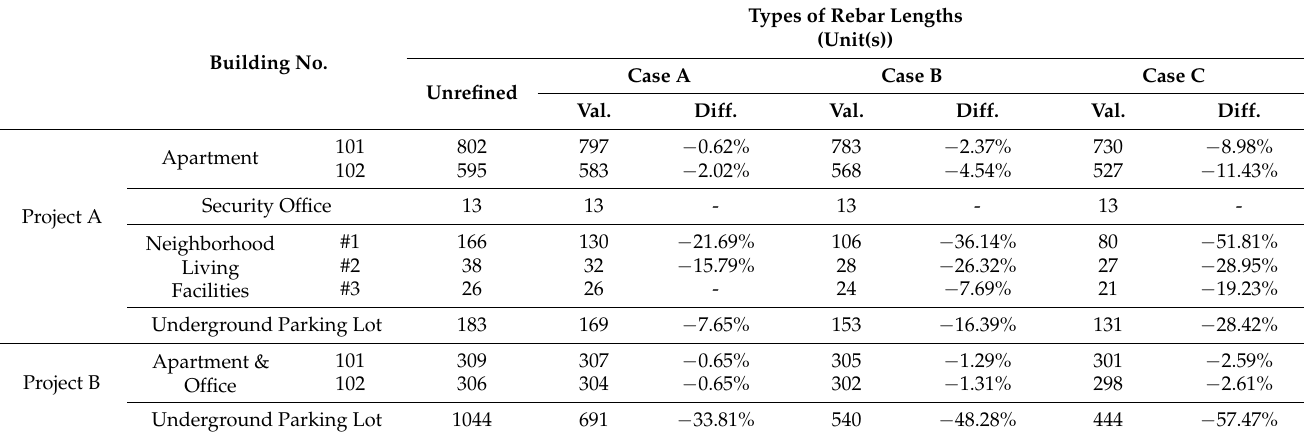
Table A7. Numbers of LPRS for Slab Members and Differentials by